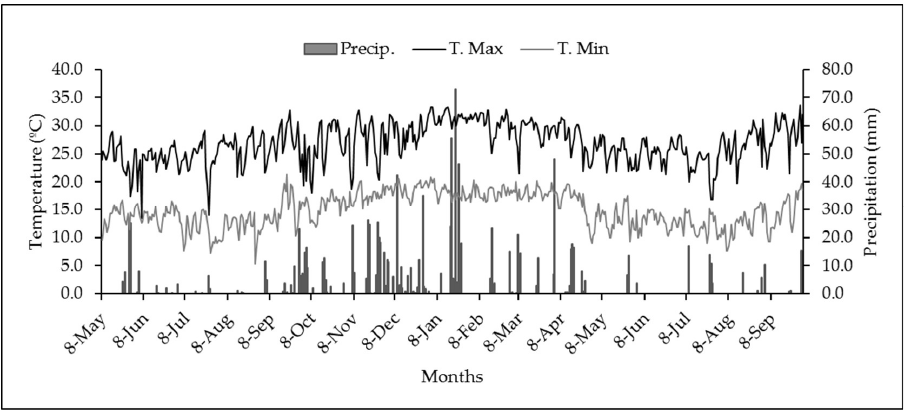
Figure 1. Temperature and precipitation during the experiment conduction.